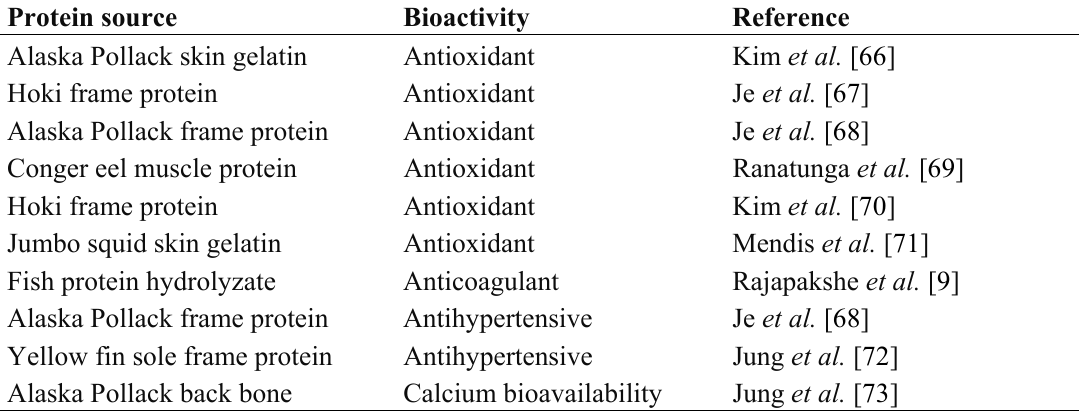
Table 2. Biological activities of bioactive peptides derived from membrane